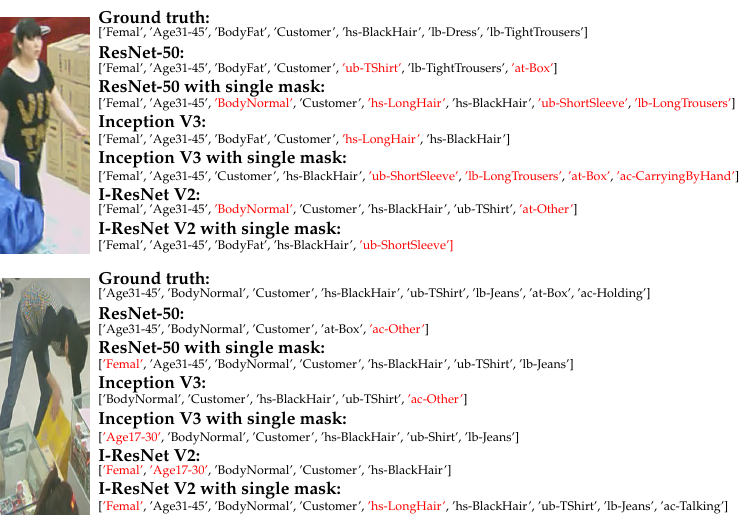
Figure 10. The examples of predicted attribute from pedestrian images corresponding to full occlu- sion, partial occlusion, and irregular posture in the first, second, and third rows, respectively, where the wrong attributes are presented as red